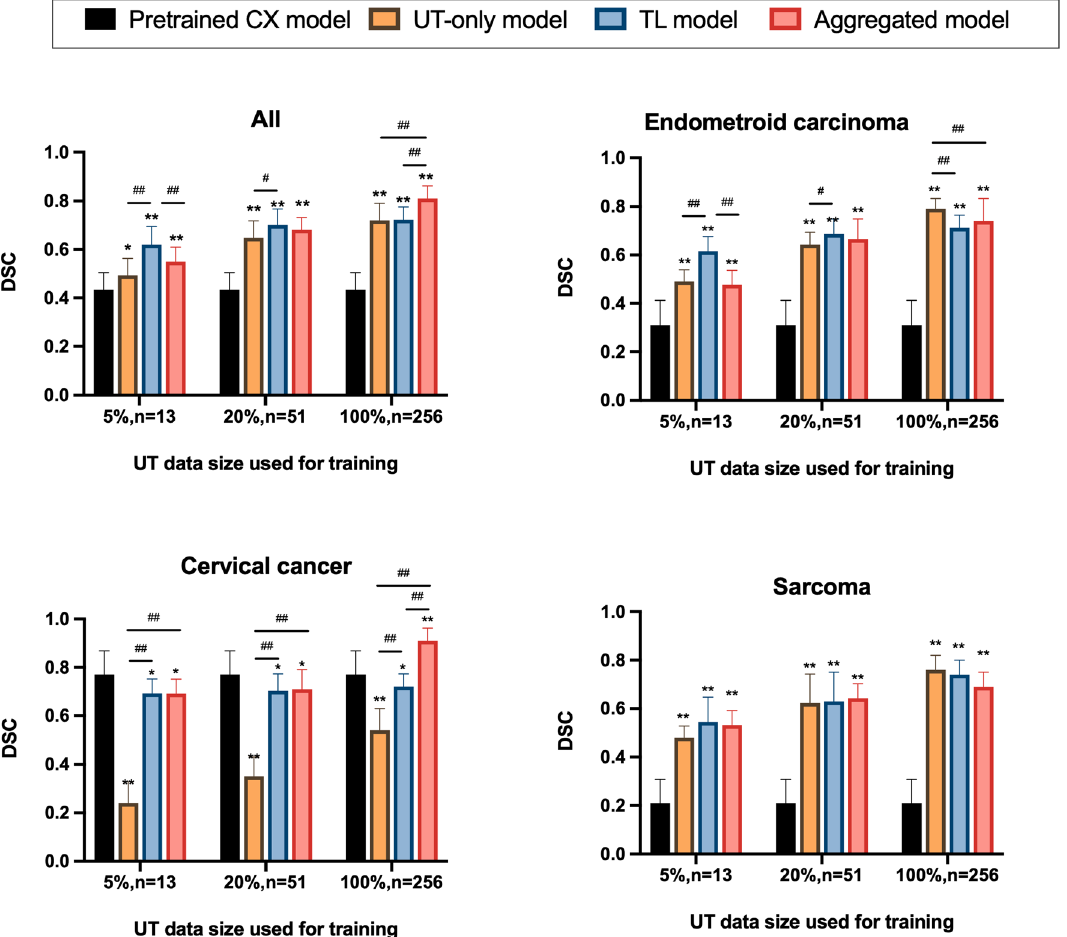
Fig. 5 Comparisons of prediction accuracies of various models for subgroup uterine malignancies using various training sample sizes of uterine tumors dataset. The transfer learning (TL) model referred the fine‑tuning level of L1. *, significant different compared with the pretrained model; #